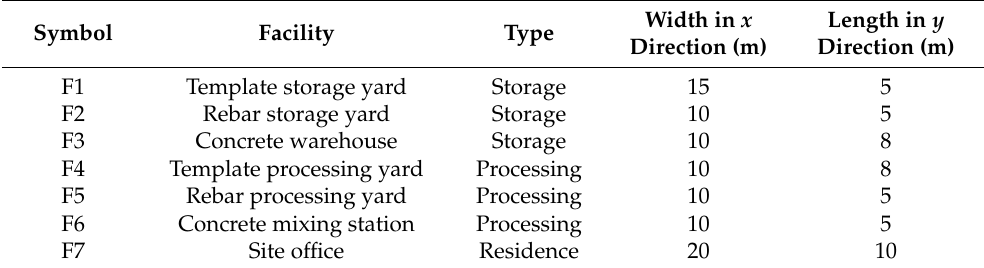
Table 1. The required facilities and their dimensions.